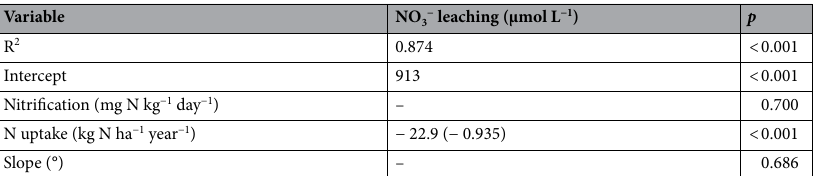
Table 2. Coefficient of determination and regression coefficients of multiple linear regression of NO 3 − leaching. Numbers in parentheses indicate standardized coefficients. Stepwise F <